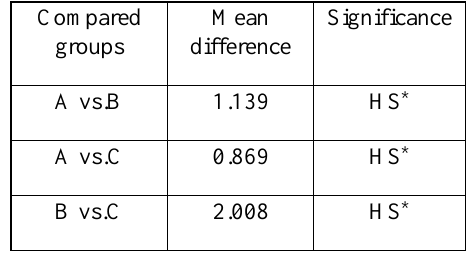
Figure 3: radiograph showing the radiopacity values of G-aenial composite in relation to the density of aluminum step wedge